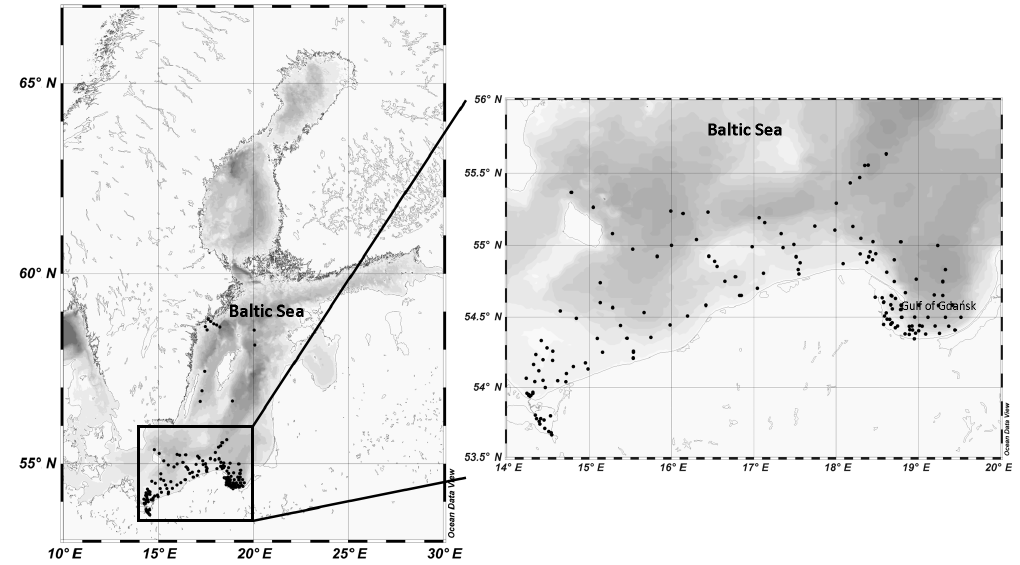
Figure 1. Locations of all the sampling stations in the Baltic Sea; enlarged view of the study